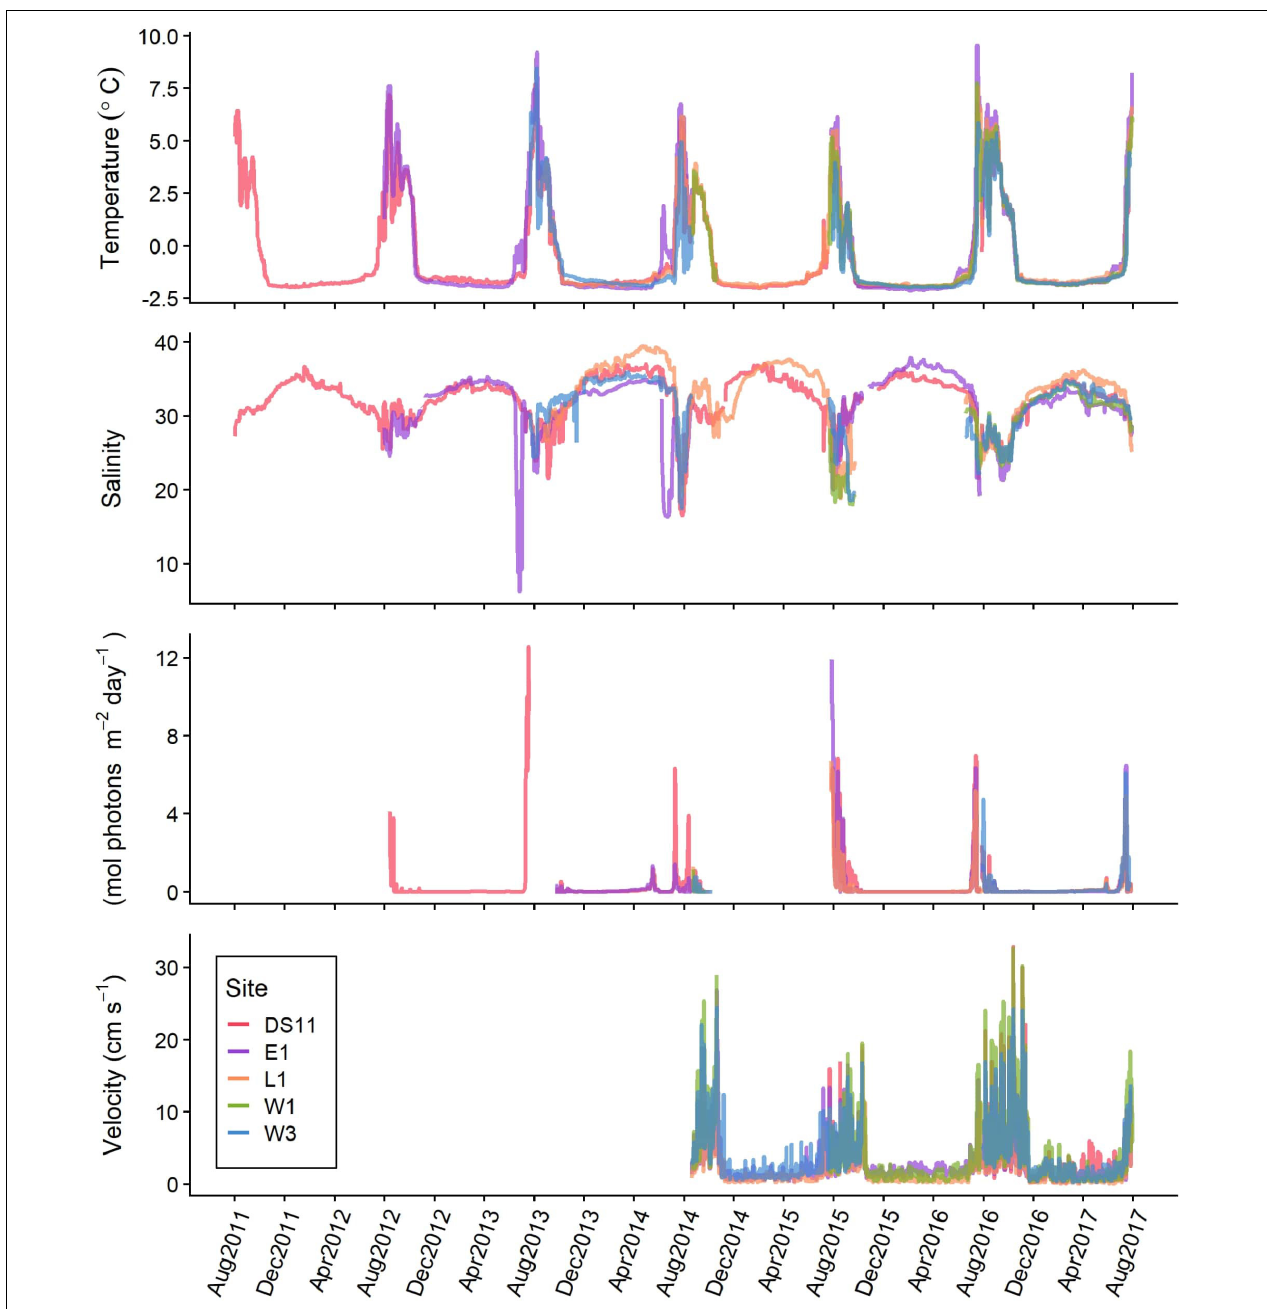
FIGURE 2 | Timeseries of benthic temperature ( ◦ C), salinity, photosynthetically active radiation (PAR, mol photons m − 2 day − 1 ), and horizontal current velocity (cm s − 1 ) at each site within Stefansson Sound ( Figure 1 ), August 2011–August 2017. Values represent daily mean conditions.